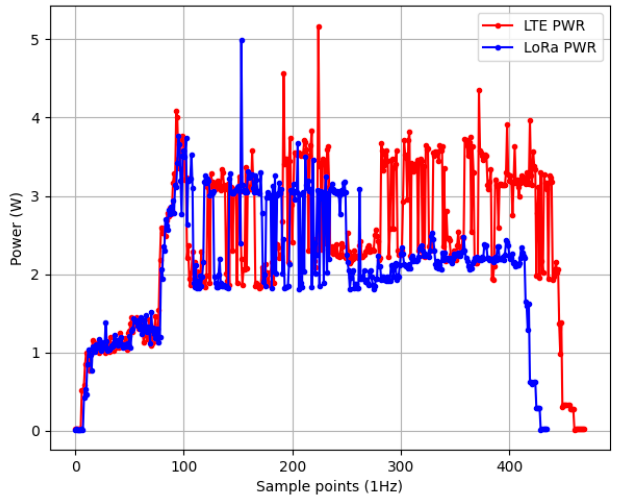
Figure 11. Power consumption of the circuit with different communication modules.